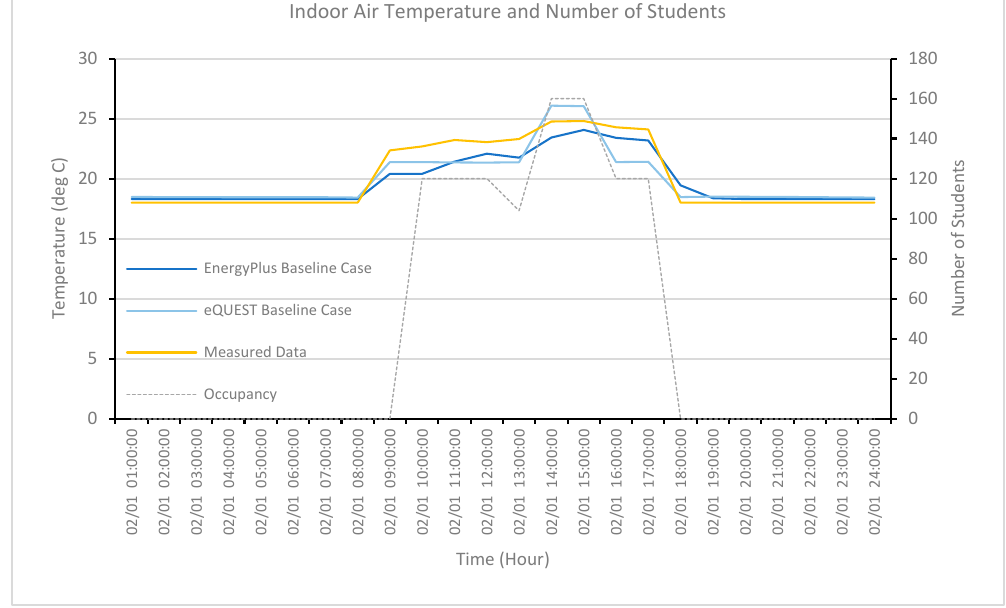
Figure 7. Simulated indoor air temperature compared to the measured data during occupied hours,